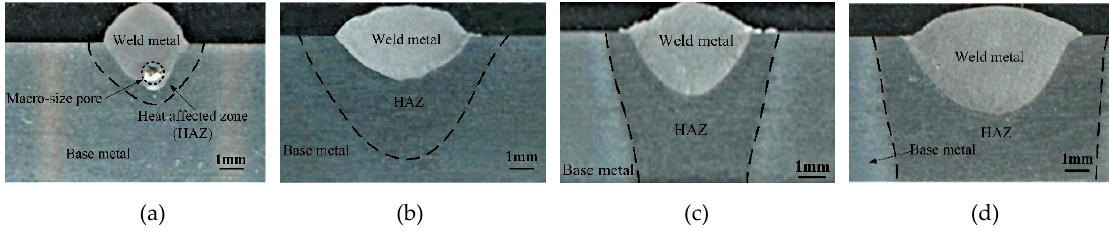
Figure 4. Experimental results of the weld cross-section under different welding currents: ( a ) I = 100 A, ( b ) I = 140 A, ( c ) I = 160 A, and ( d ) I = 200 A.